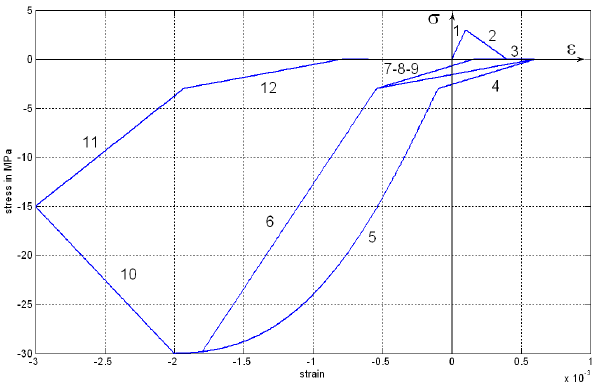
Fig. 7. Uniaxial behavior at the crack level. The stress-strain curve is plotted in the crack referential.